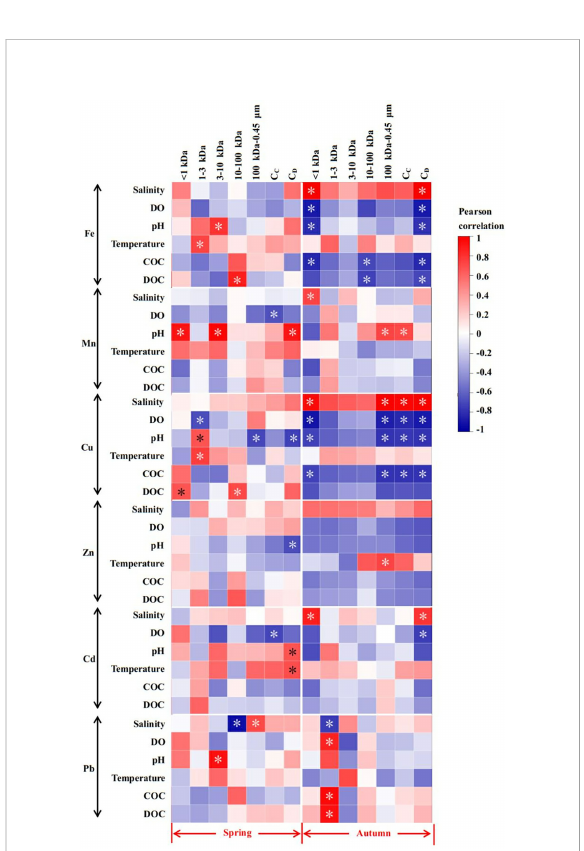
FIGURE 7 Pearson correlation matrix for the concentrations of dissolved Mn, Fe, Cu, Zn, Cd and Pb and the physicochemical parameters in different seasons of YRE. * represents signi fi cant (P <